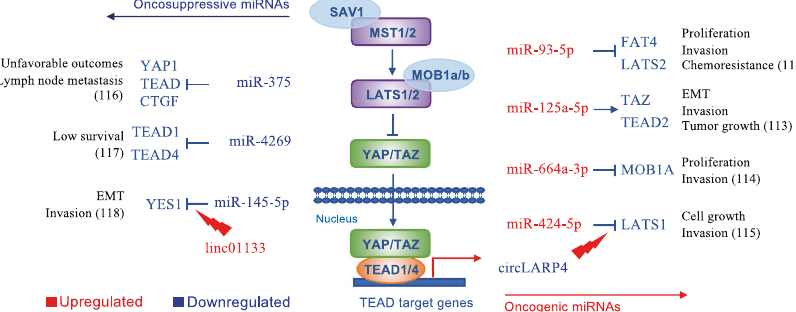
Fig. 4 miRNAs implicated in Hippo pathway dysregulation in gastric cancer. Oncogenic miRNAs activating YAP/TAZ signaling are often upregulated (in red) in human GC. By contrast, YAP/TAZ inhibiting oncosuppressive miRNAs are reported to be downregulated (in blue) in GC. For each miRNA are indicated the Hippo target/targets, and the functional effects of its/their regulation. The stable circular RNA LARP4 (circLARP4) can reverse the oncogenic role of miR-424-5p, resuming YAP phosphorylation and retention in the cytoplasm, and is often downregulated in GC. Similarly, the long intergenic non-coding RNA linc01133 competes with miR-145-5p to promote YES1-dependent YAP1 nuclear translocation and is upregulated in GC tissues.